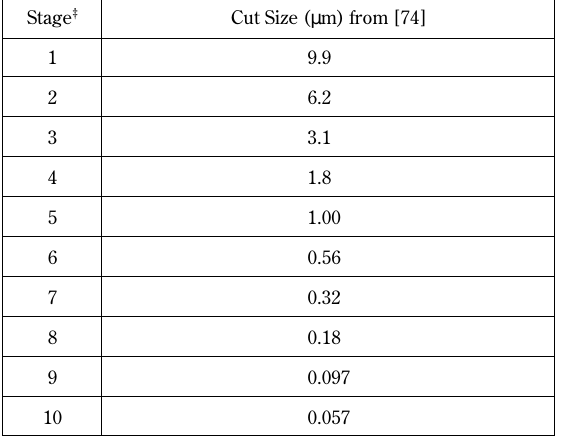
Table 9 Stage d 50 values for the Model 110 † MOUDI at 30